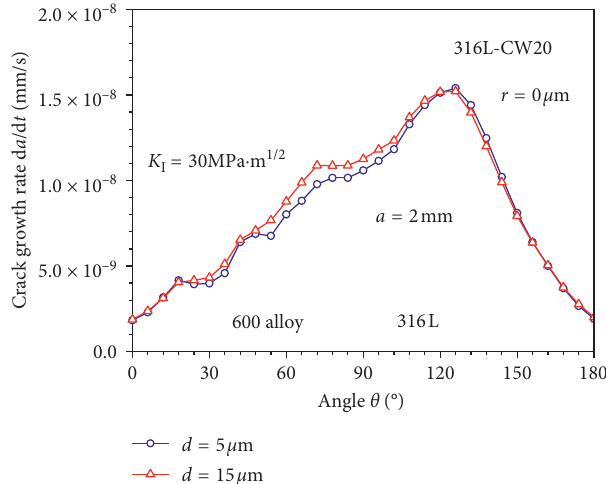
Figure 15: Comparison of the crack growth rate at different distances from the fusion